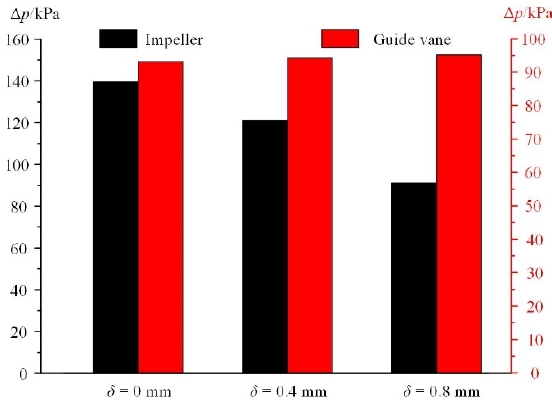
Figure 15. The pressure increment in the impeller and the guide vane.